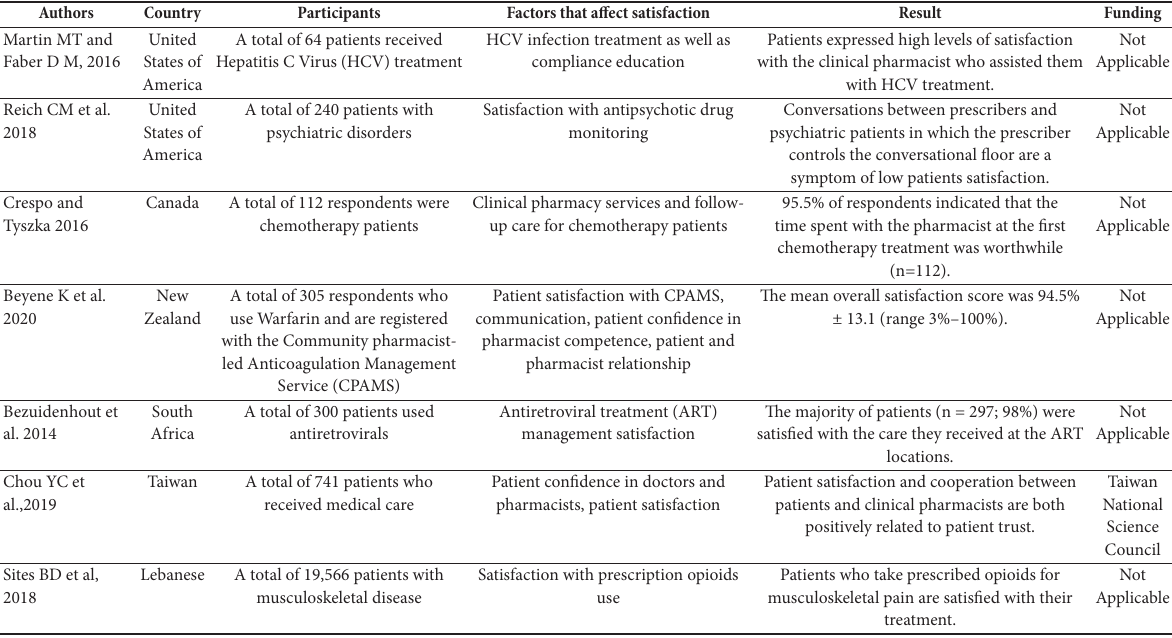
Table 3. Patient satisfaction with drug therapy monitoring